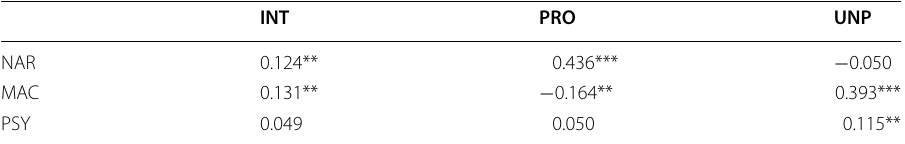
Table 6 SEM hypotheses testing